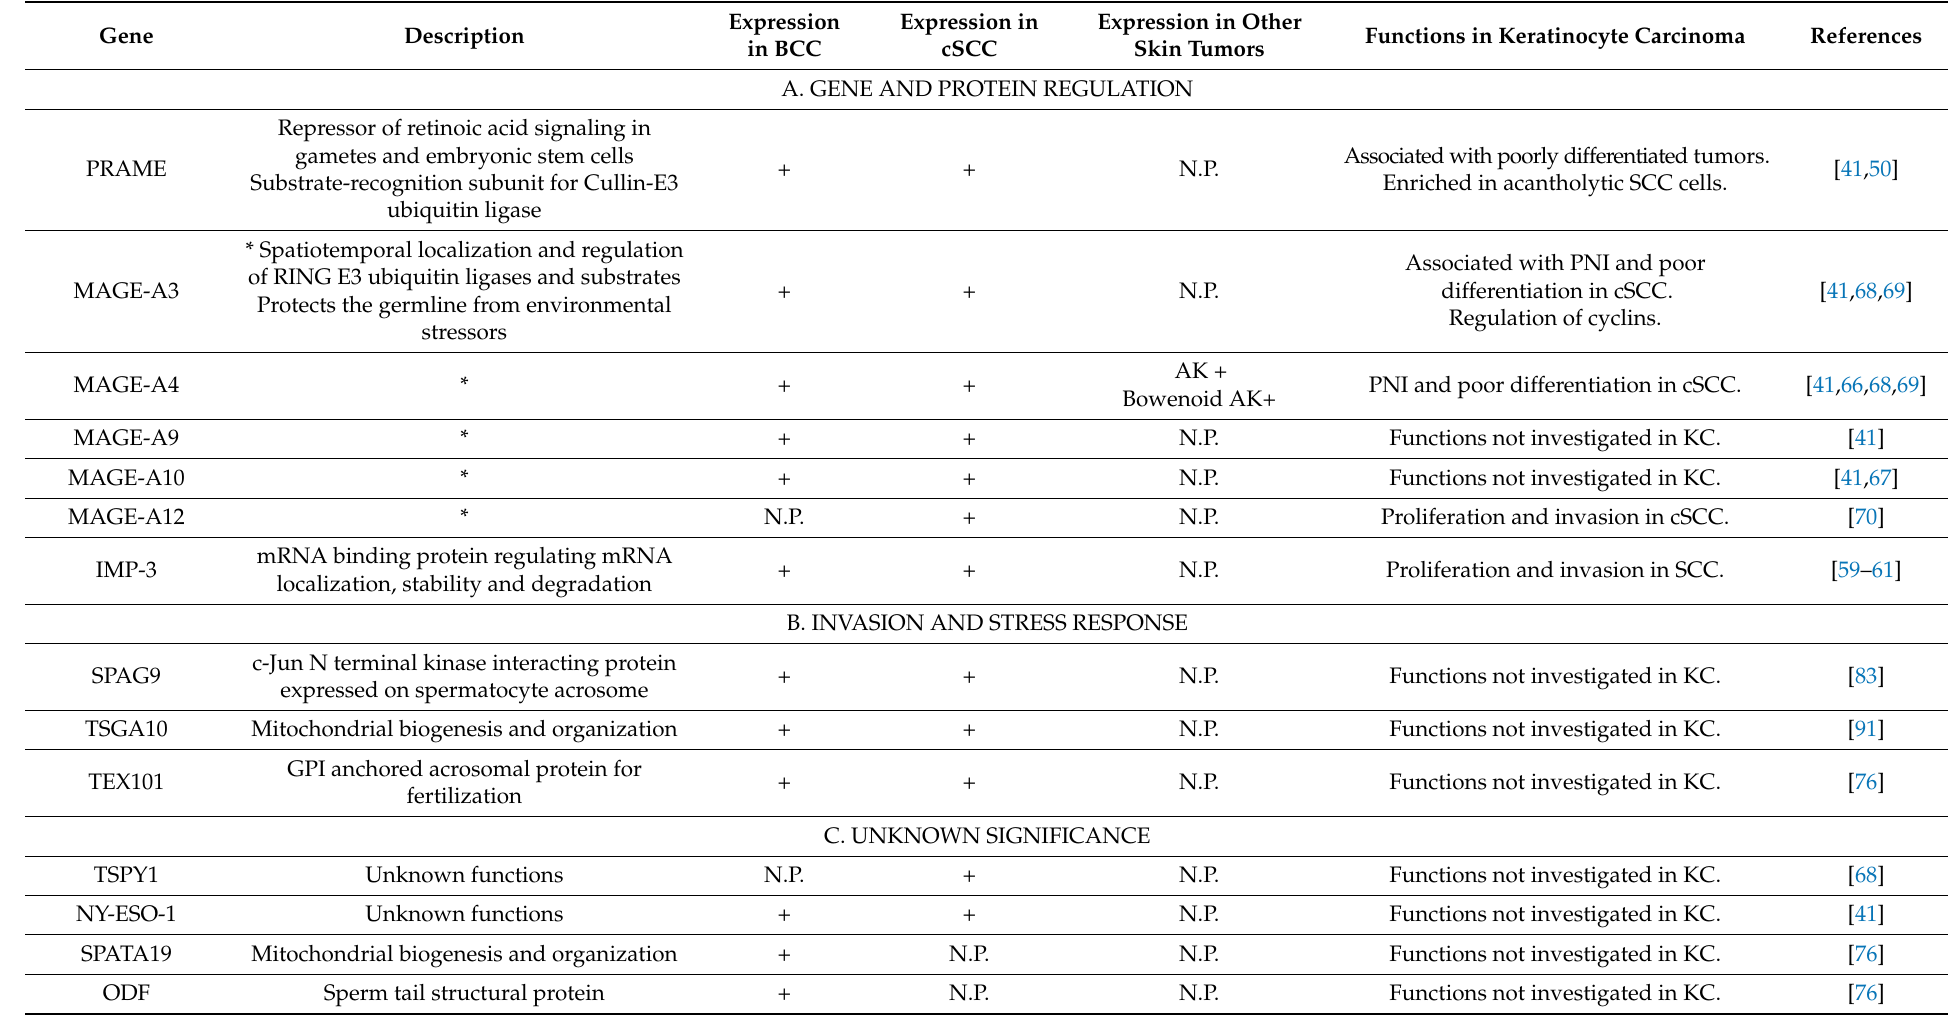
Table 1. Expression and functions of CTAs that are known to be expressed in KCs. * Description for all MAGE-A proteins are the same. +: positive expression. N.P: Not Profiled. AK: Actinic